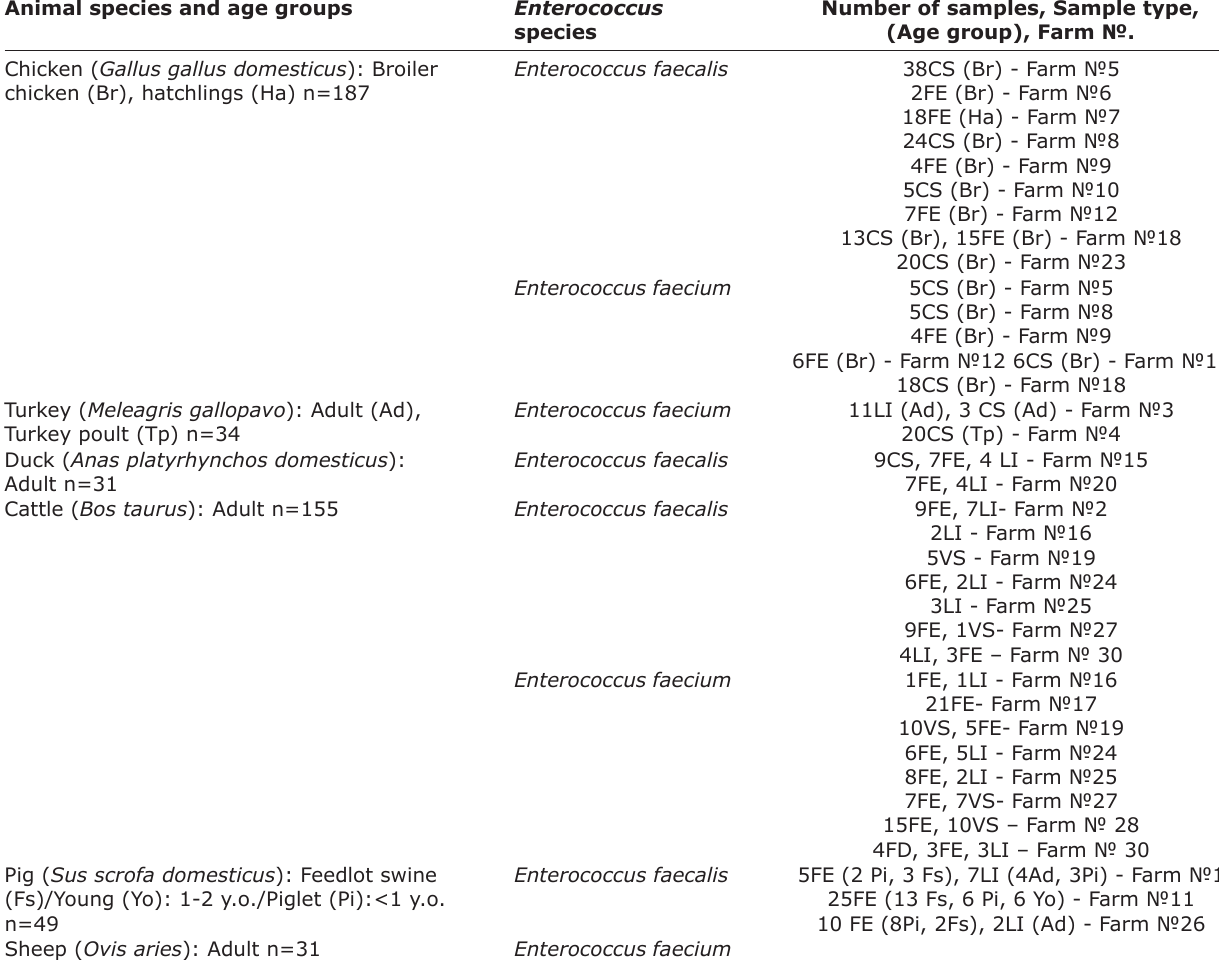
Table-1: The number of samples depending of farm, sample type, and age group. Animal species and age groups Enterococcus